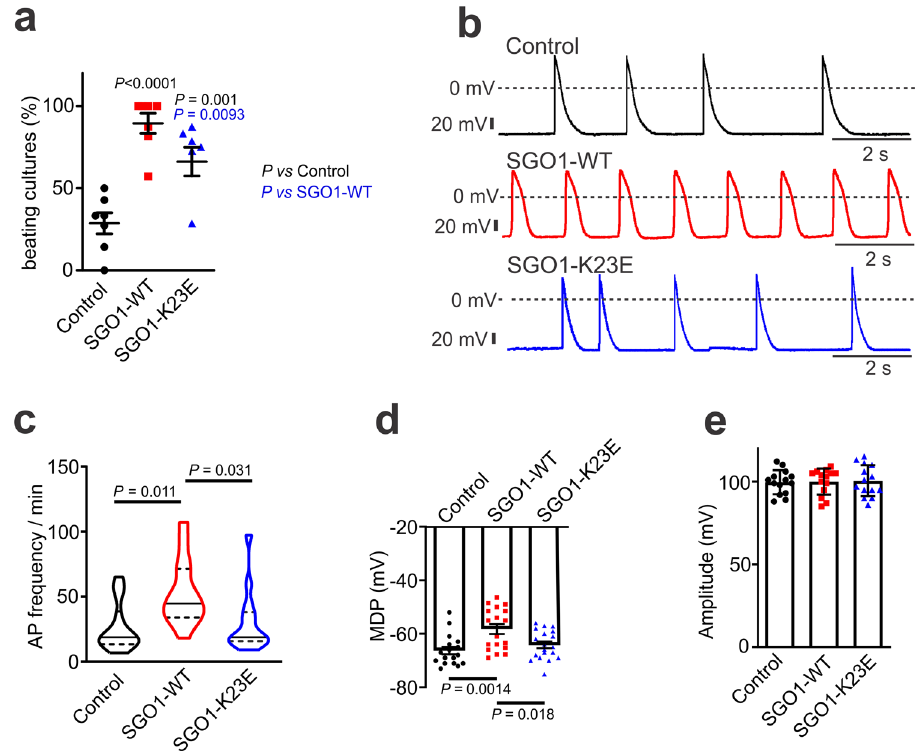
Fig. 1 SGO1-WT promotes automaticity of NRVMs. a Transduction of SGO1-WT increased the number of spontaneously beating NRVM monolayers compared to control and SGO1-K23E transduced NRVMs after 30 to 48 h transduction; SGO1-K23E had weaker effects than WT on NRVMs. Each point in the plot represents the percentage of wells of a 24-well plate that were beating for each experiment. n = 7 biologically independent experiments with independent preparations on different days. Data are expressed as mean ± SEM. One-way ANOVA with Tukey ’ s multiple comparison test. b Representative action-potential (AP) recordings in NRVM monolayers of control (black), SGO1-WT (red) and SGO1-K23E (blue) transduced preparations. The short vertical lines at left are 20 mV scales. c SGO1-WT transduction promoted spontaneous AP fi ring in NRVMs compared to control and SGO1-K23E. n = 14 biologically independent cells per group. Data are represented as violin plots, with median (solid line) and interquartile range (dotted line). One-way ANOVA with Tukey ’ s multiple comparison test. d Reduction of MDP in SGO1-WT NRVMs. n = 17 – 19 biologically independent cells per group. Data are expressed as mean ± SEM. One-way ANOVA with Tukey ’ s multiple comparison test. e Effect of SGO1-WT and SGO1-K23E transduction on AP amplitude in NRVMs. n = 14 biologically independent cells/group. Data are expressed as mean ±